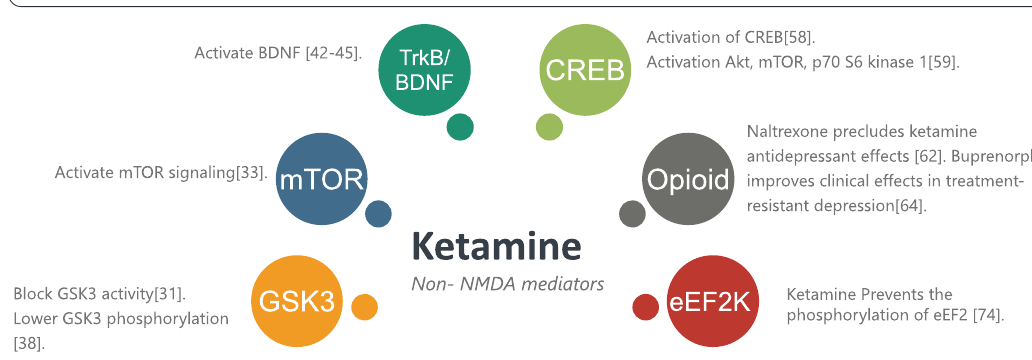
Figure 2. Main mechanisms underlying non-NMDA-mediated affects of ketamine.